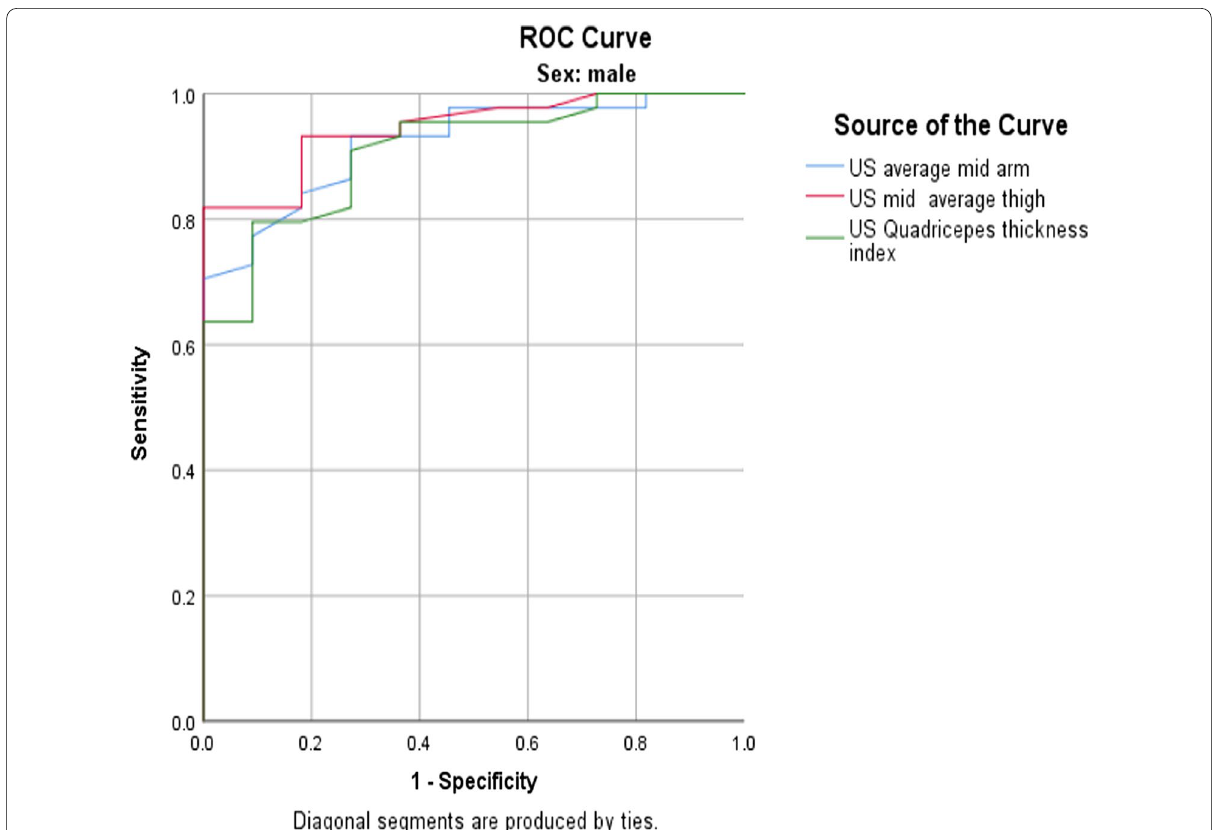
Fig. 9 Cut off values for female muscle layer thickness